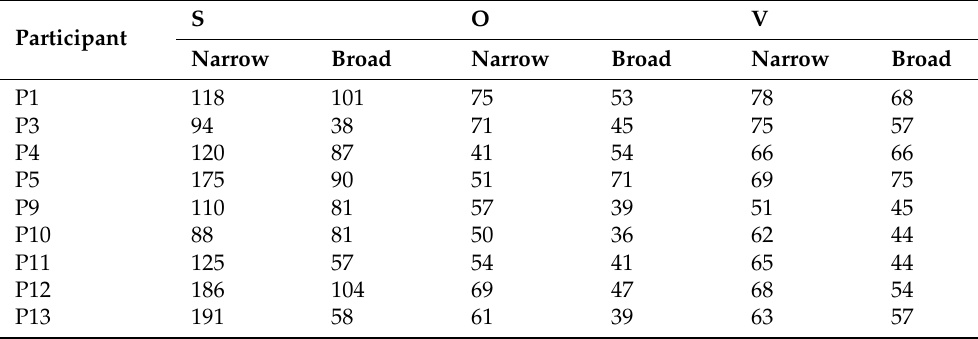
Table 3. Mean duration values (in ms) obtained from utterances with narrow focus on the subject and with broad focus displayed by